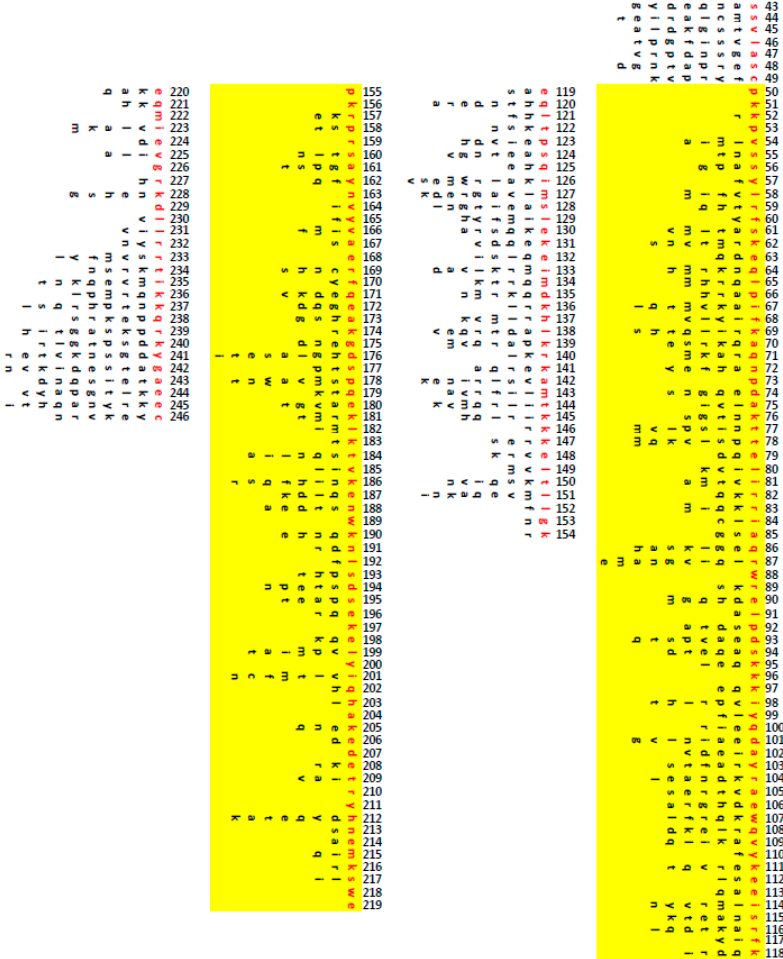
Figure 5 . Conditionally permissive substitutions in hTFAM. The numbering corresponds to aa position in hTFAM precursor (before MTS removal). Red font, aa in wt hTFAM. Black font, conditionally permissive substitutions at each position. Yellow highlights, HMG1 and HMG2 domains.